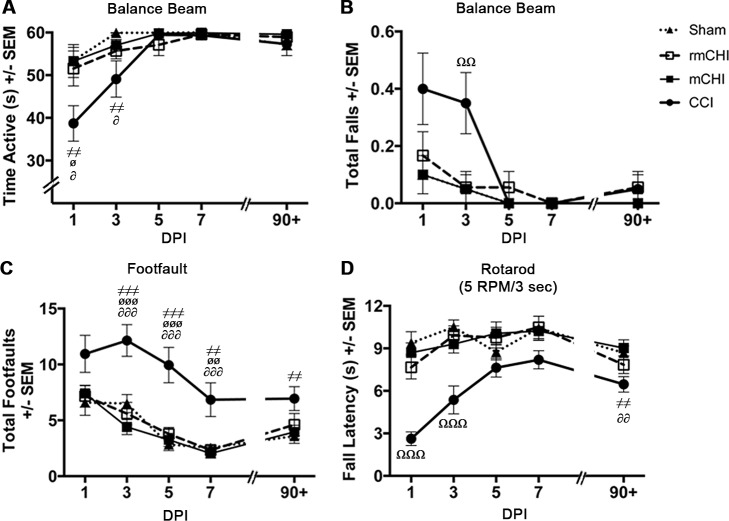
Motor deficits are evident in the CCI, but not mCHI or rmCHI mice.(A) At 1 dpi, CCI mice spent significantly less active time on the beam than sham (≠≠p<0.01), rmCHI (øp<0.05), and mCHI (∂p<0.05) mice. They also spent significantly less time being active on the beam at 3 dpi than sham (≠≠p<0.01) and mCHI (∂p<0.05). (B) At 3 dpi, the CCI mice fell off the balance beam significantly more often than the other injury groups (ΩΩp<0.01). (C) rmCHI and mCHI mice exhibited no deficits on the foot fault task, but CCI mice had more foot faults than shams, rmCHI, and mCHI mice at 3 dpi (≠≠≠p<0.001, øøøp<0.001, and ∂∂∂p<0.001, respectively), 5 dpi (≠≠≠p<0.001, øøøp<0.001, and ∂∂∂p<0.001), and 7 dpi (≠≠p<0.01, øøp<0.01, and ∂∂∂p<0.001). CCI mice still had significant deficits at 90+ dpi versus shams (≠≠p<0.01) and mCHI (∂p<0.05) mice. (D) CCI, but not mCHI or rmCHI, mice performed significantly worse on the accelerating rotarod test (5 RPM every 3 sec) at 1 and 3 dpi (ΩΩΩp<0.001). These deficits were still present at 90+ dpi compared to shams (≠≠p<0.01) and mCHI mice (∂∂p<0.01).